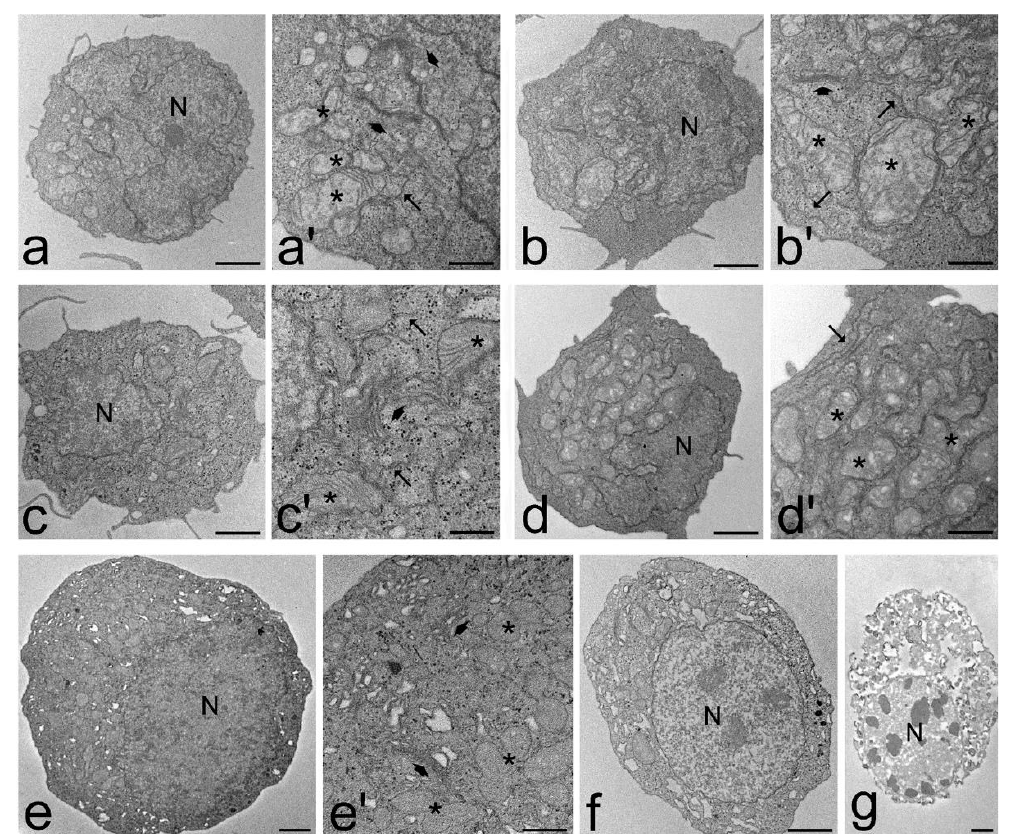
Figure 3. TEM micrographs of Jurkat cells after 24 h from treatment: control ( a , a’ ), O 2 ( b , b’ ), 10 µg O 3 ( c , c’ ), 20 µg O 3 ( d , d’ ), 30 µg O 3 ( e , e’ , f,g ). Nucleus (N), mitochondria (asterisks), Golgi complex (arrowheads), endoplasmic reticulum (arrows). Note the cytoplasmic vacuolization in e , e’ , and f . A necrotic cell is shown in ( g ). Bars: 1 µm ( a – f ); 500 nm ( a’ – d’ ).